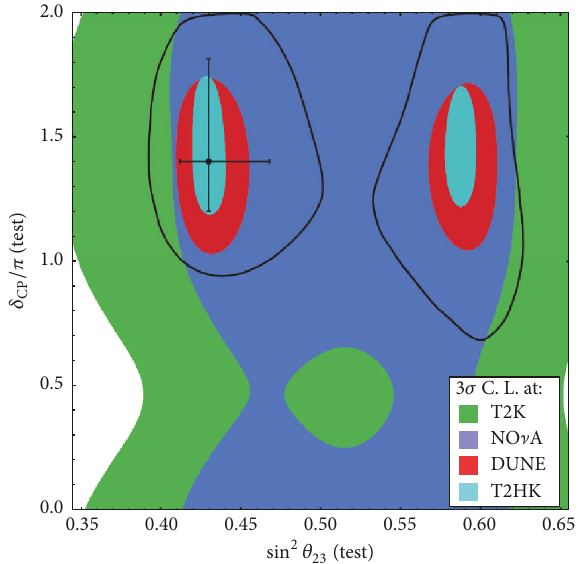
Figure 1: Expected sensitivity regions of sin 2 𝜃 23 ( test ) versus 𝛿 ( test ) assuming as the true and test model the Standard-3 ] CP paradigm for the three long-baseline detectors discussed: (1) T2K (green), (2) NO ] A (blue), (3) DUNE (red), and (4) T2HK (cyan). The black curve is current90% CL and the black point is the current best fit given in Table 3. Notice that within this assumptions the octant would remain unresolved even at 3 𝜎